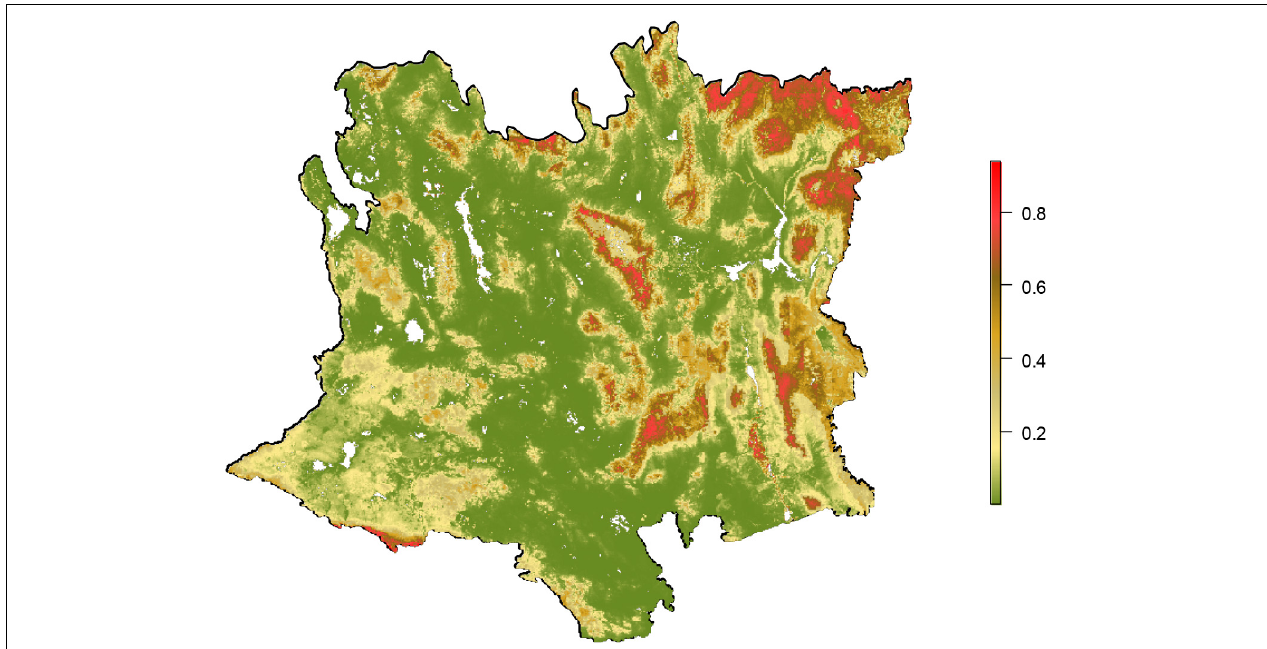
FIGURE 6 | Predicted probability of ignition in the Mojave Desert of North America. Predicted values were derived from a Maxent model (AUC = 0.967 for a test dataset) with 10 variables representing variability in topography, climate, vegetation, and lightning. Because the model was based on background and not true absence data, the predicted values are proportional to true probabilities.